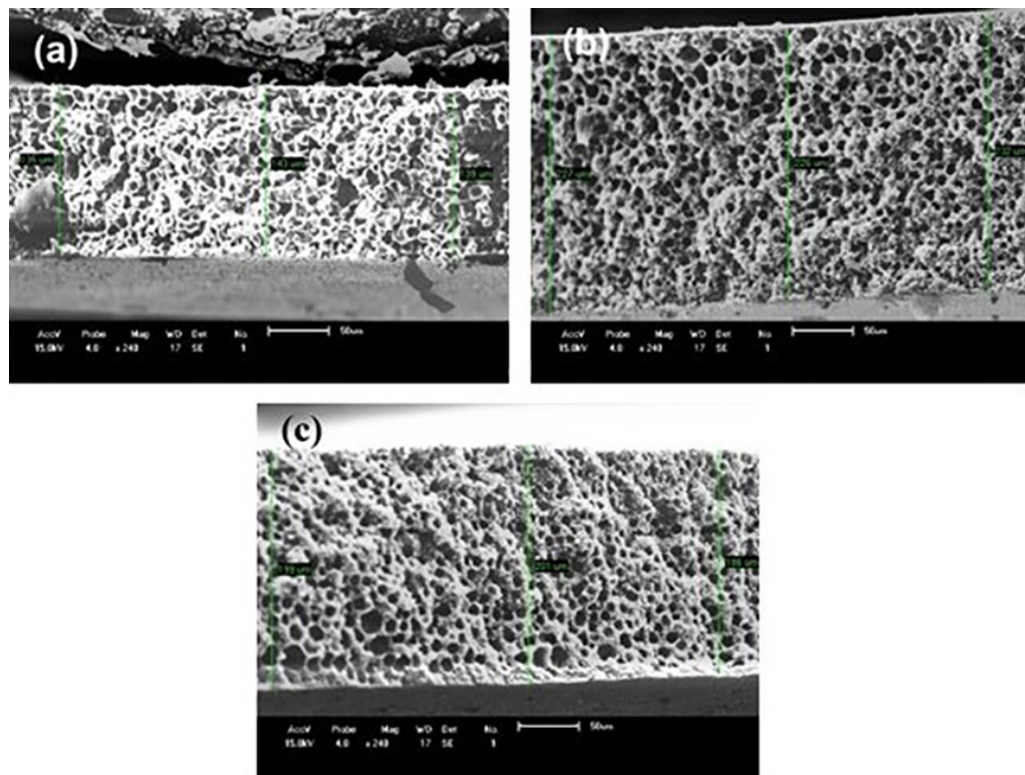
Figure 9. SEM cross-sectional images of the membranes with precipitation bath with 30% of formic acid: (a) PA6; (b) PA6 + 3%MMT and (c) PA6 + 5%MMT In the precipitation bath with 30% of formic